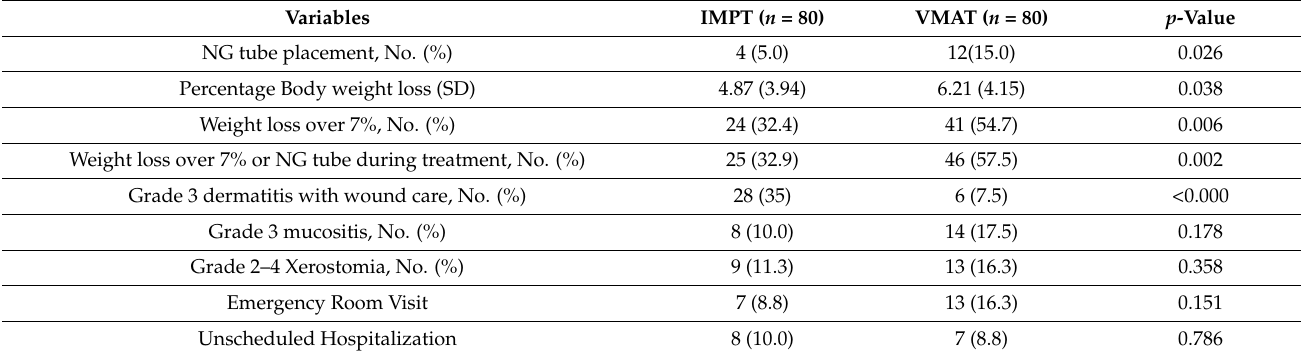
Table 3. Toxicity Analysis for planned endpoints between IMPT and VMAT plans.